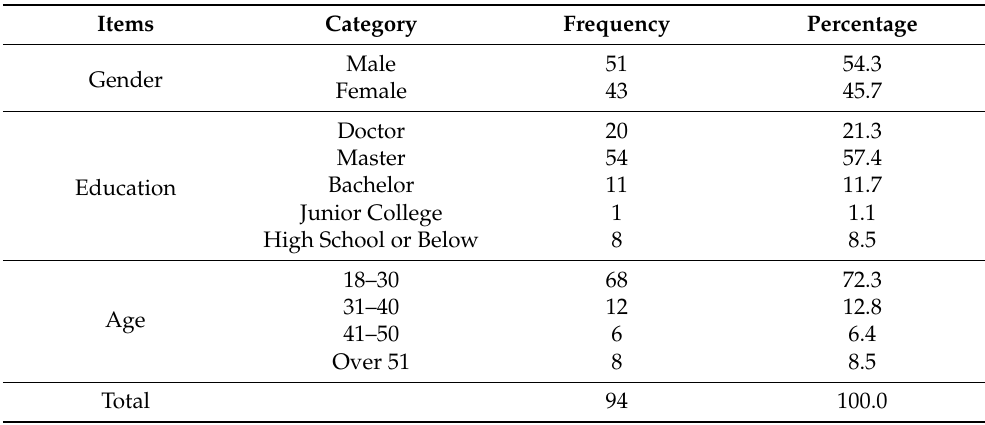
Table 1. Statistics of basic information of the questionnaire.